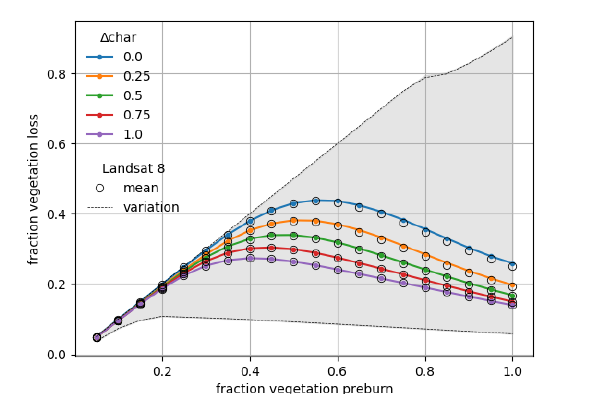
Figure A6. Vegetation loss results depending on starting vegetation fraction and ∆ char parameter setting, park-wide for Sentinel-2A, dNBR threshold = 0.15. Mean values are shown in colored lines, with total model result variation shown in gray. To compare, the results for Landsat 8 are shown in black, with mean values shown by circles and total model result variation shown by dashed lines.